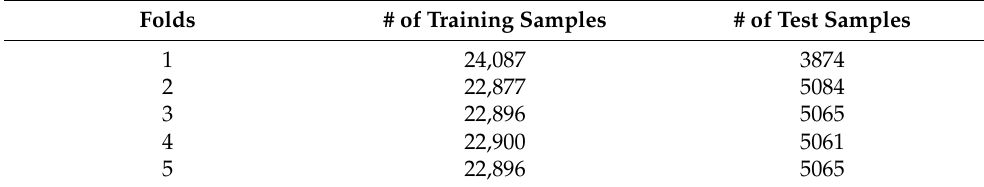
Table 4. User paper data recordings split into five user-independent folds.